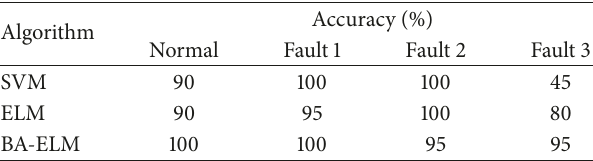
Table 2: Comparisons of SVM, ELM, and